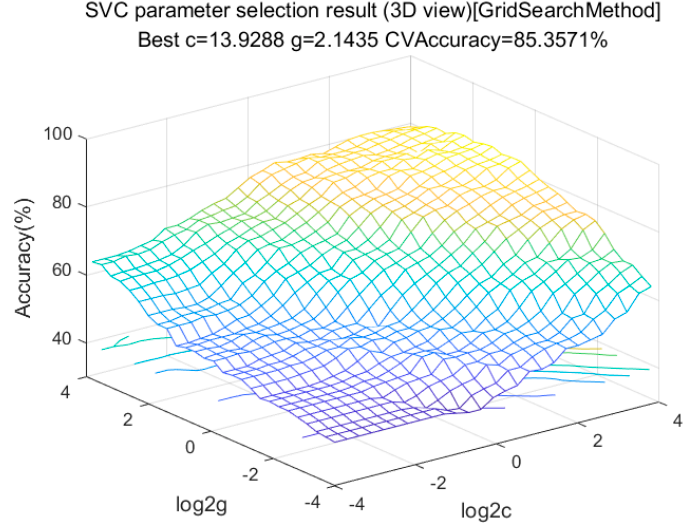
Figure 7. 10 ‐ fold cross ‐ validation of polynomial kernel optimization. Figure 7. 10-fold cross-validation of polynomial kernel